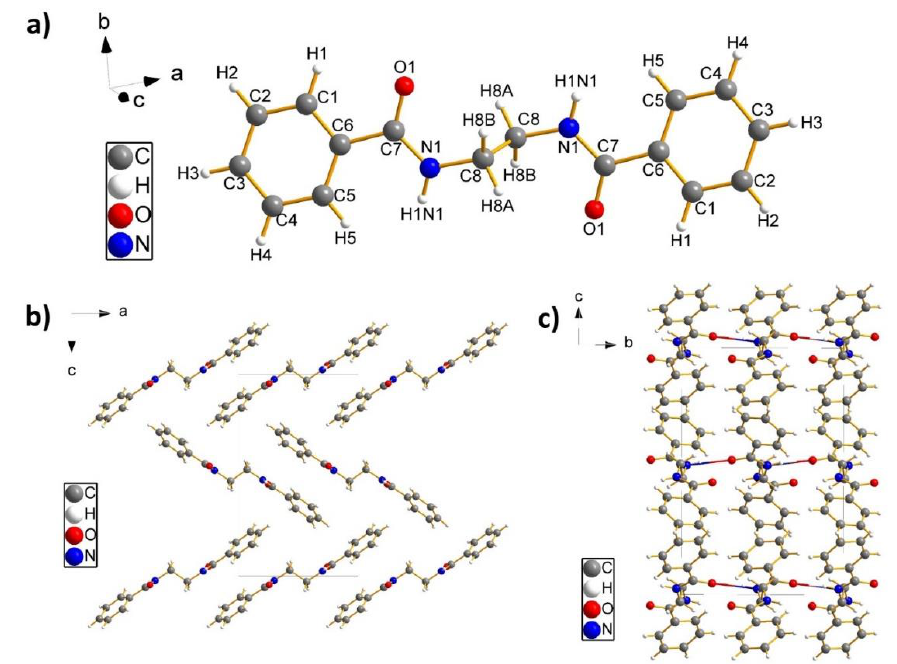
Figure 2. ( a ) Perspective view of a doubled asymmetric unit of C 16 H 16 N 2 O 2 within a unit cell of BZ6 (a centre of inversion lies between the two C8 atoms). ( b ) Dense crystal packing of BZ6 molecules along the crystallographic a-axis (view along the crystallographic b-axis). ( c ) Crystal Packing of BZ6 molecules (view along the crystallographic a-axis) with hydrogen bonding networking (two-coloured bonds) running along the crystallographic b-axis.